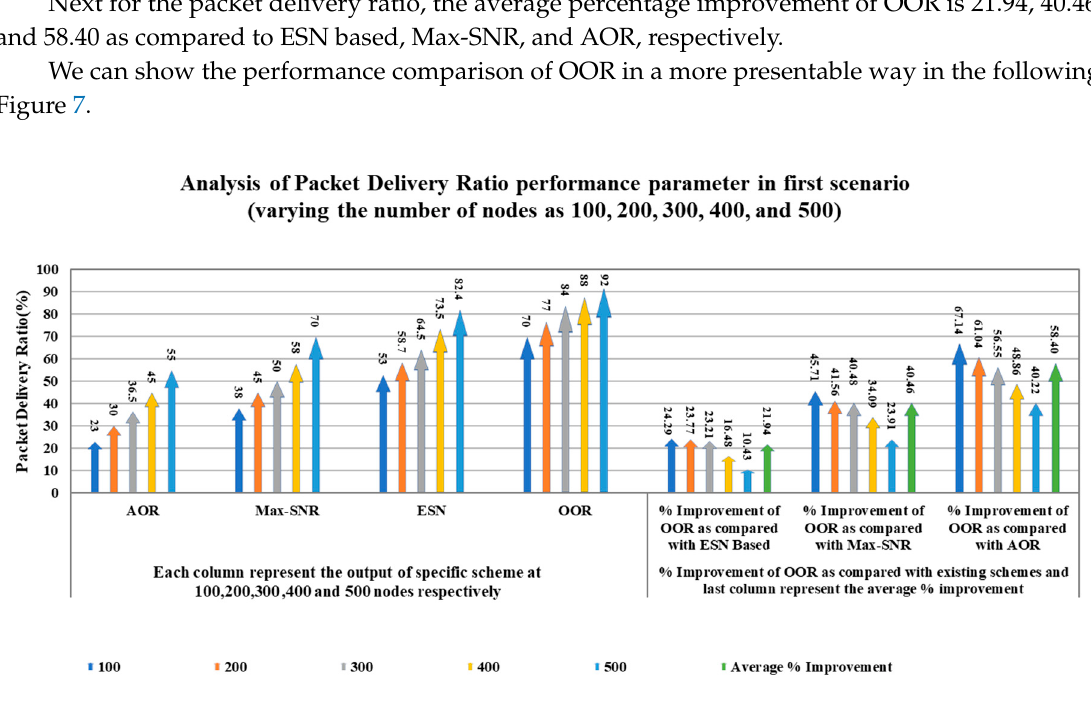
Table 2. Descriptive observations of OOR performance in terms of packet delivery ratio.